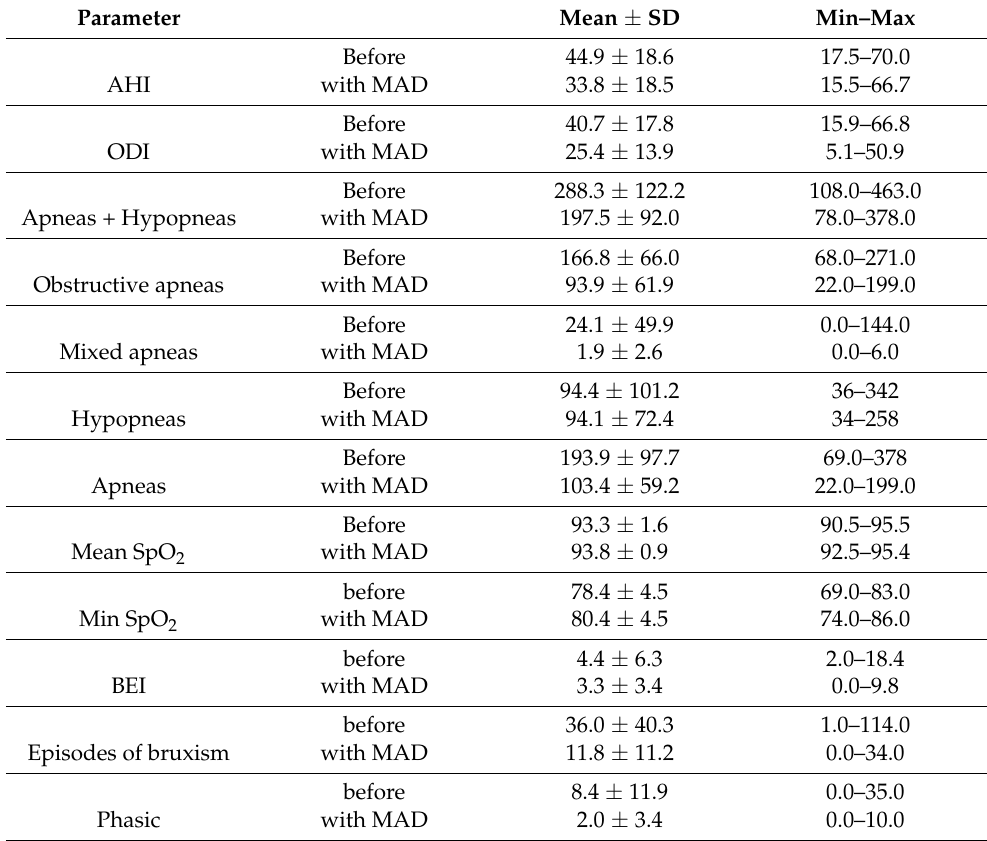
Table 2. Comparison of all of the variables examined before and after the MAD application (N = 8).